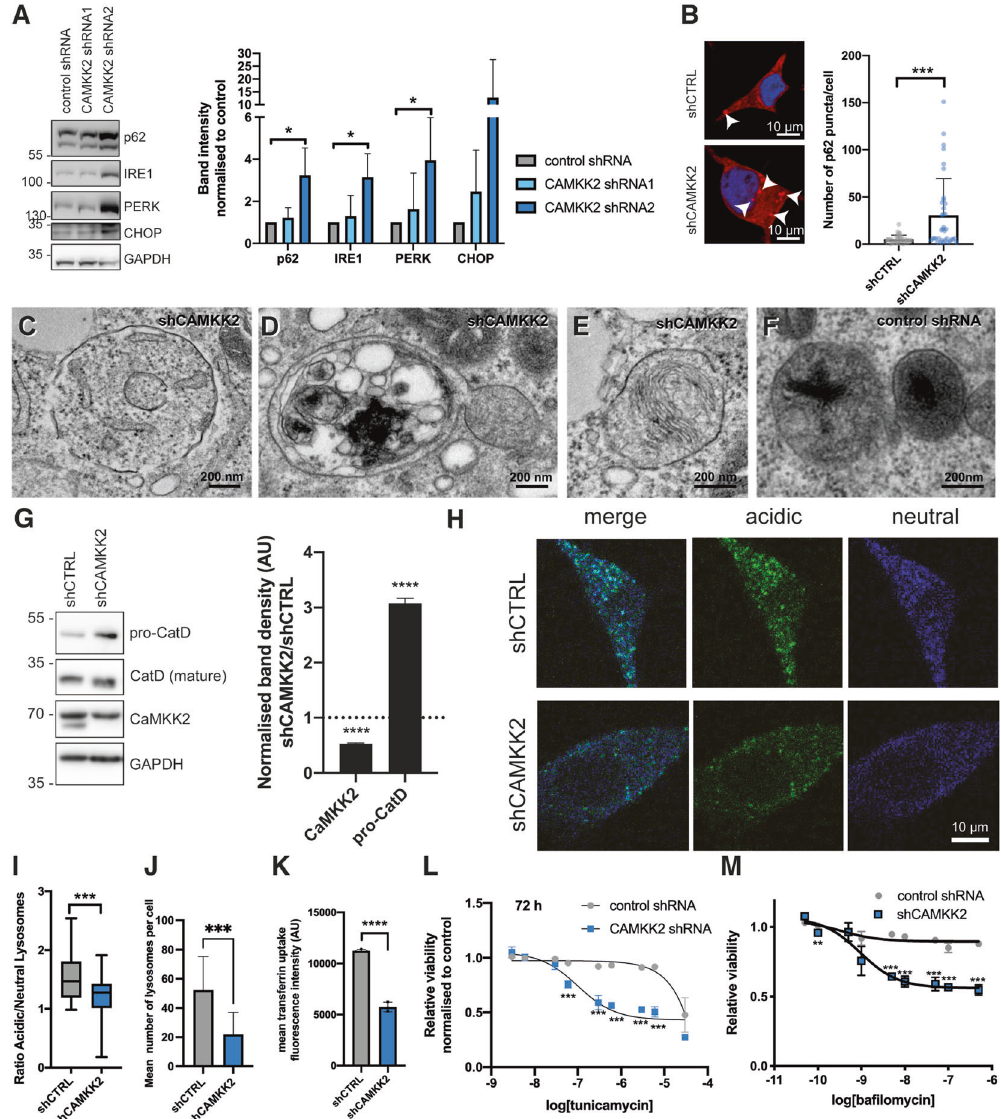
Fig. 5 Loss of CaMKK2 results in ER stress and an increased sensitivity to a lysosomal acidi fi cation inhibitor. A Representative western blot of unfolded protein response (UPR) and autophagy proteins: p62, IRE1, PERK, CHOP, in CAMKK2 knockdown LNCaP cell lysates. Densitometry was normalised to loading control for each sample. N = 3 for IRE1 and N = 4 for PERK and LC3. Mean ± SD; * P < 0.05. B Representative confocal images of control and CAMKK2 knockdown (shRNA2) LNCaP cells stained for p62 and DAPI. The number of p62 puncta (arrow heads) were analysed in 35 cells across 3 replicates. Mean ± SD; *** P = 0.0002. Scale bar = 10 µm. C , D Representative transmission electron microscopic (TEM) images of CAMKK2 knockdown (shRNA2) LNCaP cells showing autolysosomes including hemi-fused autophagosome-lysosome structures. Scale bars 200 nm. E , F Representative TEM images showing the lysosome morphology in CAMKK2 knockdown (shRNA2) and control shRNA cells. Scale bars 200 nm. G Quanti fi cation of uncleaved pro-Cathepsin D in cell lysates from control and CAMKK2 knockdown (shRNA2) cells by western blotting. Graph displays values from shCAMKK2 normalised to the control knockdown, mean ± SD, N = 3, P < 0.0001. H Representative multiphoton live cell images of LNCaP cells stably expressing control or CAMKK2-targeting shRNA and stained with Lysosensor DND-160. Scale bar 10 µm (for all images). I Quanti fi cation showing the ratio of acidic:neutral lysosomes using CTFC values for blue/green channels. Thirty-eight cells were analysed across three replicates. The box and whisker plot show 5 – 95 percentile with the mean indicated with a line; *** P = 0.0002. J The mean number of lysosomes per cell were quanti fi ed from the Lysosensor DND-160 data. Mean ± SD for 15 cells in three replicates; *** P = 0.0002. K Uptake of Alexa647-transferrin for 10 min was measured to investigate the endocytosis of the transferrin receptor. Samples were analysed by a FACS assay showed a signi fi cant reduction compared to control in the CaMKK2 knockdown LNCaP cell line. The bar graph shows mean with SD, N = 3 with 3 technical repeats per experiment that each analysed the mean fl uorescence of 10,000 cells. **** P < 0.0001, two-way ANOVA. L A viability assay showing the tunicamycin dose response at 24, 48 and 72 h in LNCaP control and CaMKK2 knockdown. Mean ± SD; * P < 0.05; ** P < 0.01; *** P < 0.001. M A viability assay showing the response of CaMKK2 shRNA2 LNCaP cells to increasing concentrations of Ba fi lomycin A1 dose at 72 h normalised to control. Mean ± SD; ** P < 0.01; *** P < 0.001.